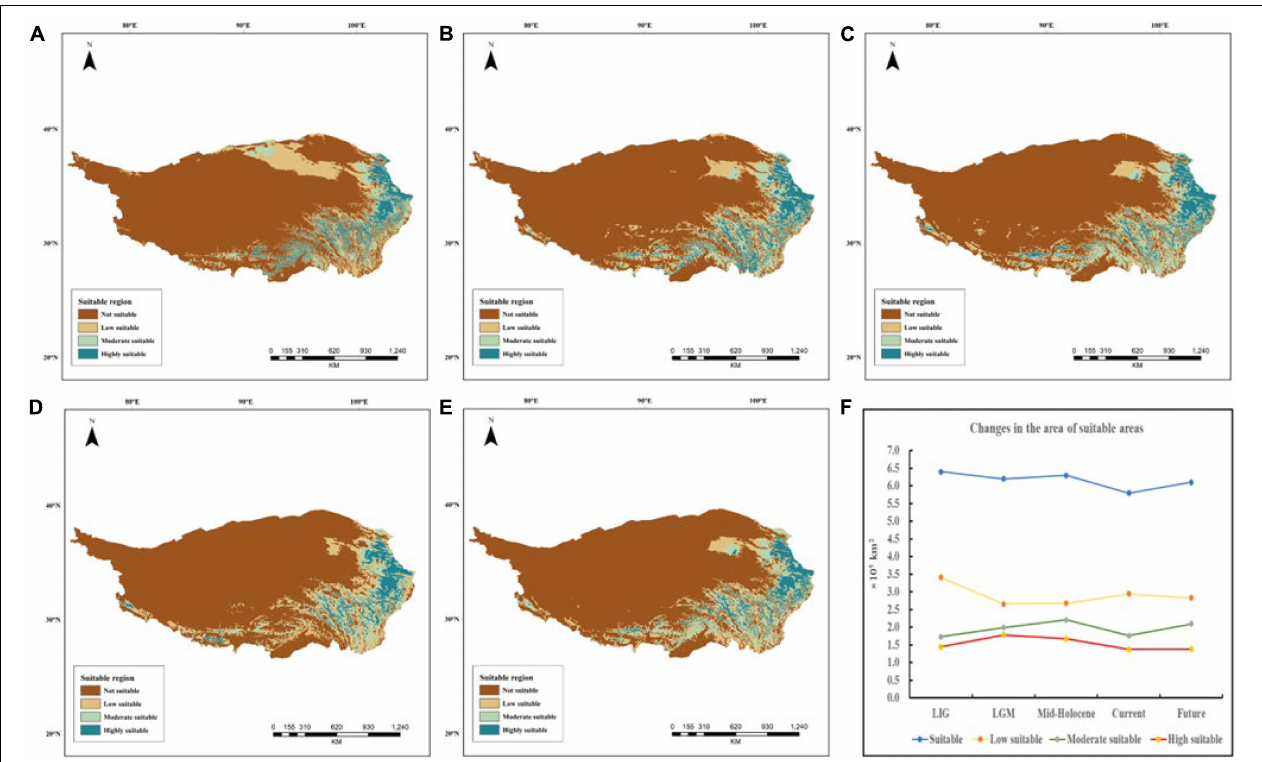
FIGURE 11 | Suitable distribution maps of E. sibiricus during different periods on Qinghai–Tibet Plateau (A) the Last Inter Glacial period (LIG ∼ 120,000–140,000 years ago); (B) Last Glacial Maximum (LGM ∼ 22,000 ya); (C) Mid-Holocene (6,000 years ago); (D) present ( ∼ 1950–2000); (E) projected future (2070); (F) changes of suitable areas at different levels in five